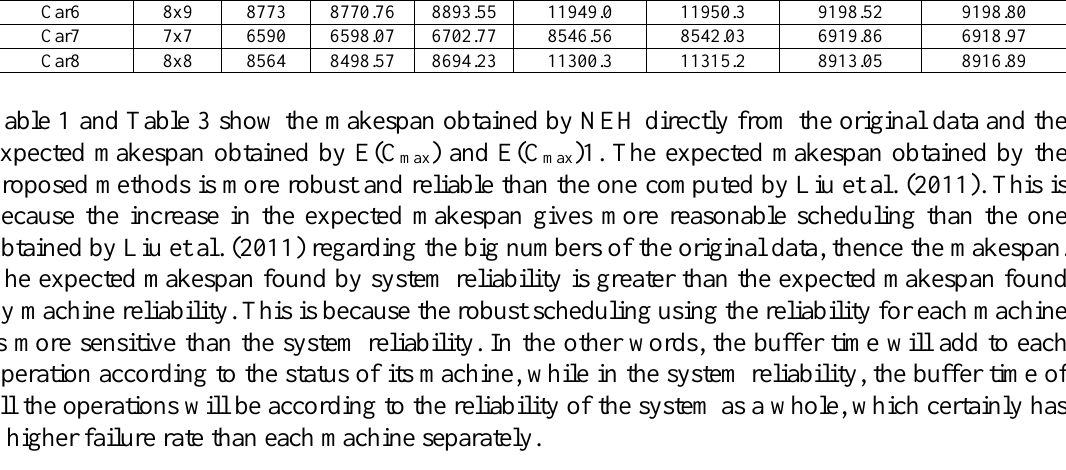
Table 2. Computational results for car problems exponentially